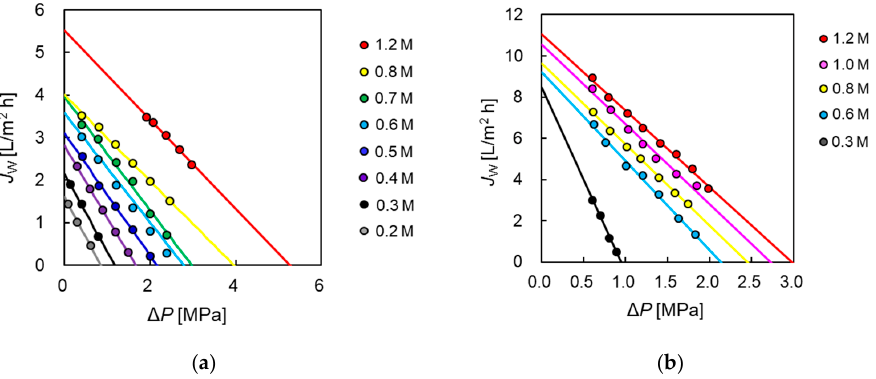
Figure 8. Water flux, J w , as a function of applied hydraulic pressure difference, Δ P , at Q DS = 10.0 L/min and Q FS = 5.0 L/min: ( a ) PA-SW and ( b ) CTA-HF membrane module.